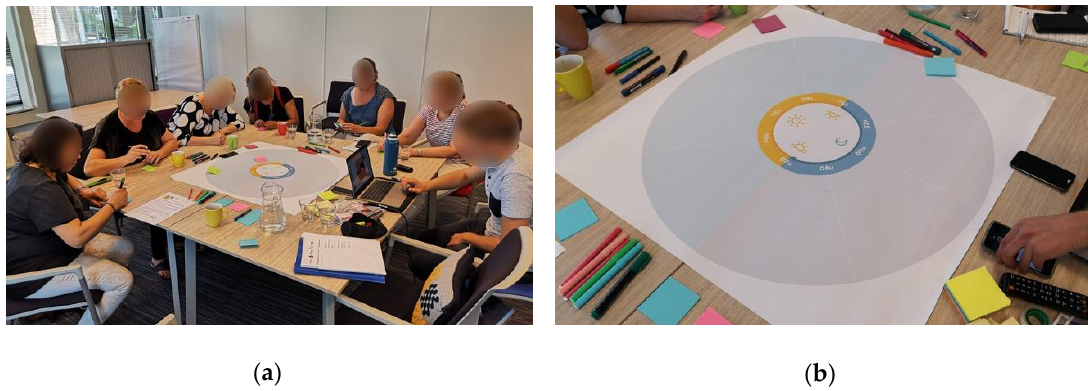
Figure 2. The caregivers mapped the typical day of a resident with dementia: ( a ) First, they were asked to reflect and make notes individually. ( b ) Next, participants were asked to share their thoughts with the group and to place their notes on the 24-h timeline.